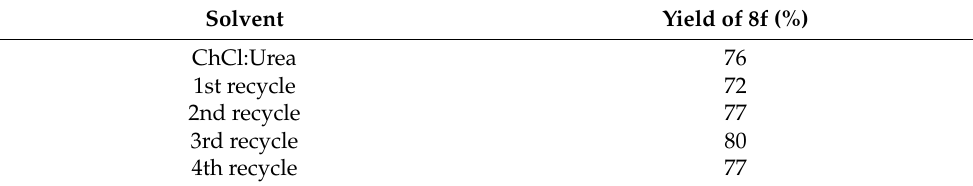
Table 3. Recyclability of DES for the synthesis of 8f